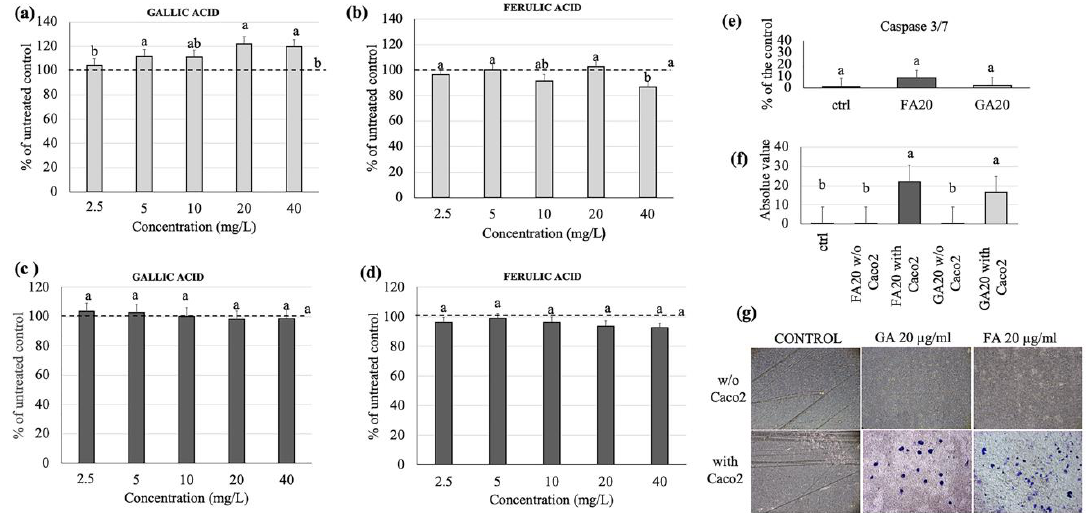
Figure 4. Gallic and ferulic acid effects on U937 monocytes cell proliferation and viability. U937 cells were treated with gallic and ferulic acids (2.5, 5, 10, 20 and 40 mg/L) respectively. The MTT ( a , b ) and viability assays ( c,d ) were performed 24 h after treatment. For caspase 3/7 analysis, U937 cells were treated with gallic and ferulic acids, respectively, at 20 mg/L or diluent as the control. After 24 h, cells were stained with CellEvent™ Caspase-3/7 Green Detection Reagent ( e ). U937 cell migration was measured as indicated in the Materials and Methods section, either with or without Caco2 cells. The mean number ± SD of migrated cells were counted and data are expressed as percentage of the control ( f , g ). Statistical analysis was performed, and between brackets, different letters indicate mean values that are significantly different at p < 0.05.